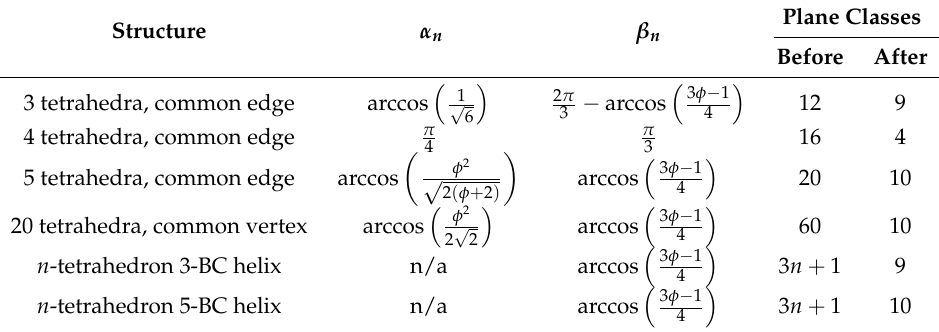
Table 1. Plane class numbers for aggregates described in Section 2.